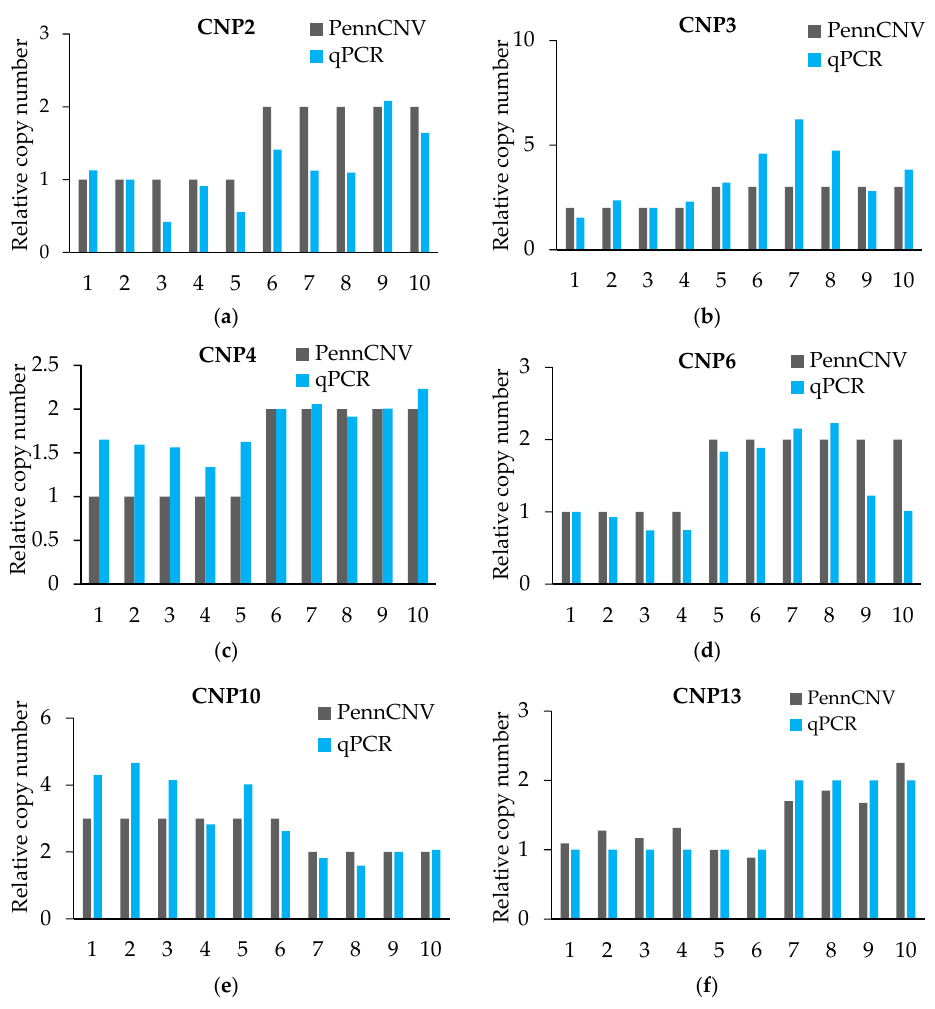
Figure 1. Quantitative real-time PCR (qRT-PCR) verified six CNPs. ( a – f ) The expression levels of CNPs are related to that of the control gene PCCA . PennCNV is a hidden Markov model (HMM)-based approach, for the kilobase-resolution detection of CNVs from Illumina high-density single nucleotide polymorphisms (SNP) genotyping data Table 5. qRT-PCR results verifying six CNPs.